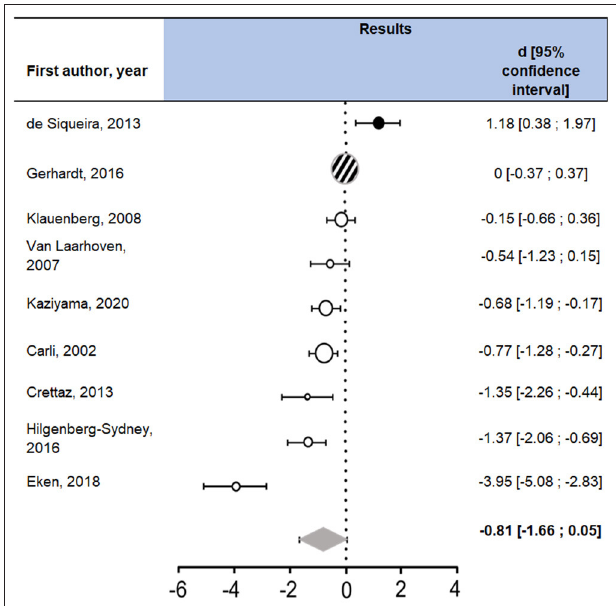
FIGURE 3 | Studies included in the meta-analysis with measures of TPT. FM, participants with fibromyalgia; HC, healthy controls; SD, standard deviation. Question marks indicate non-reported data. A positive d (in black) can be interpreted as a hypoalgesia in participants with fibromyalgia compared to healthy controls, whereas a negative d (in white) means there is a hyperalgesia in participants with fibromyalgia compared to healthy controls. Gerhardt et al.’s study indicated a d equal to zero, represented by a striped circle. The summarized Cohen’s d is represented by the gray diamond. Confidence intervals containing zero means the d is not statistically